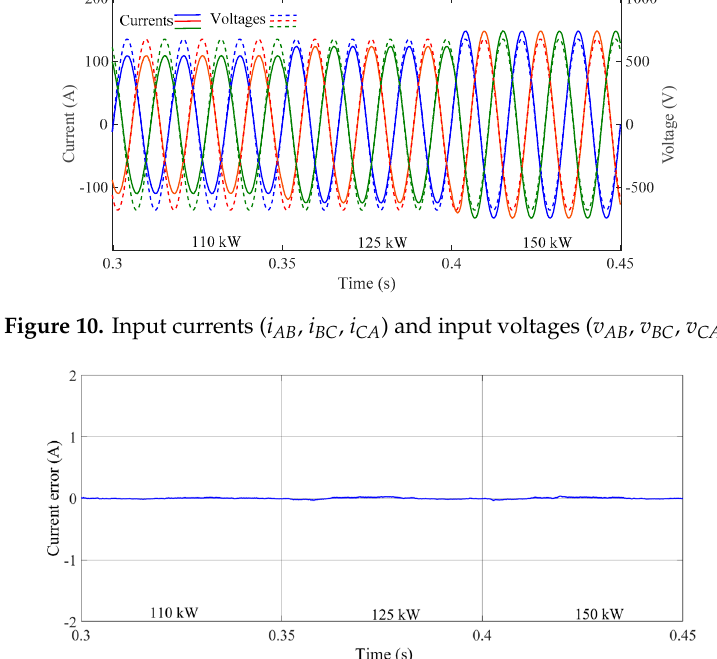
Figure 11. Current error ( x 1 − r AB ) .